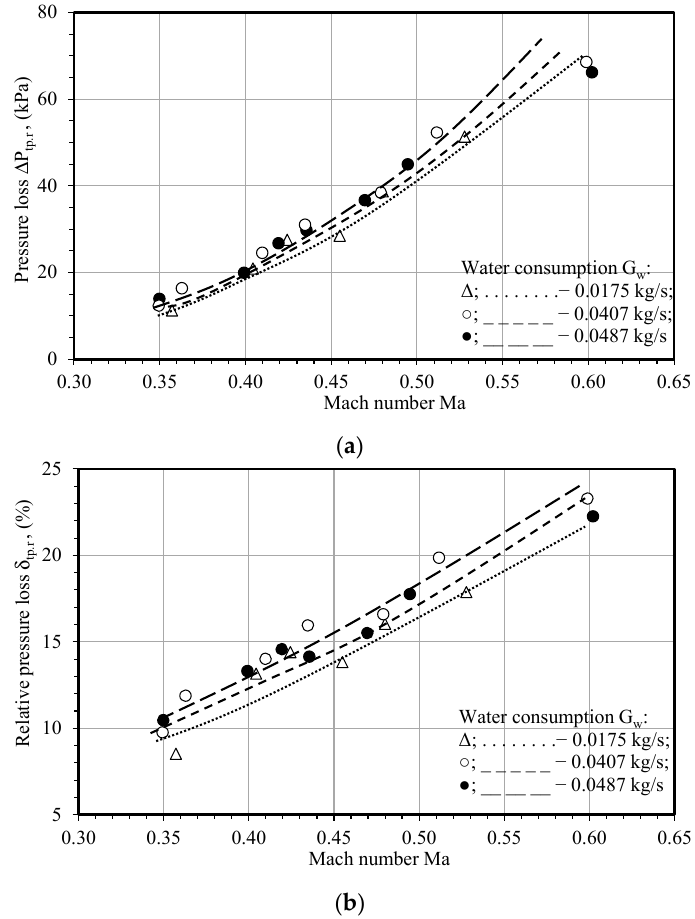
Figure 6. Measurement experimental data of pressure losses ( a ) and relative pressure losses ( b ) in the flow part of the thermopressor depend on the relative velocity M in the evaporation chamber.